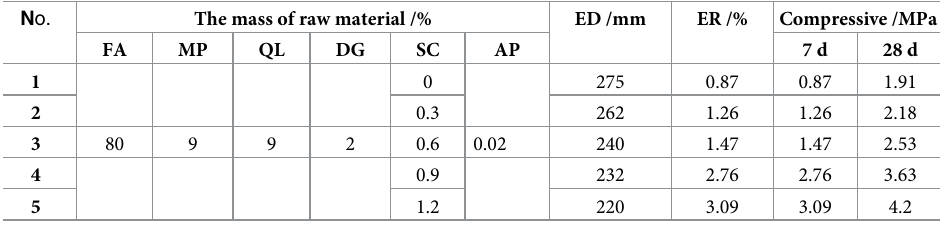
Table 4. Influence of sodium carbonate amount on material performance. N